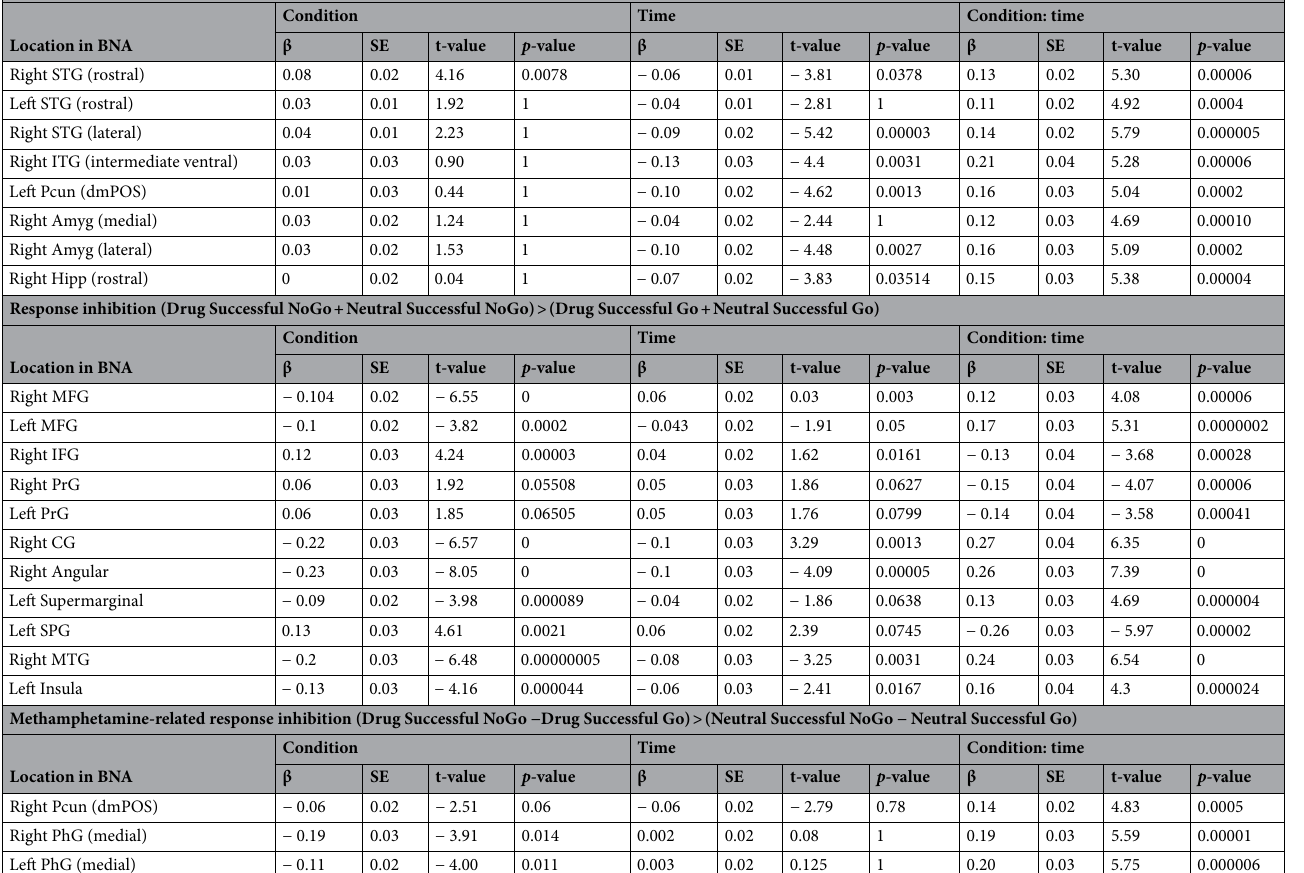
Table 2. Regions with significant condition by time interactions in the cue-reactivity and methamphetamine- related response inhibition linear mixed effects (LME) models. All p- values are FDR-corrected. FDR p-value threshold: 0.001. The p-values less than 1.0e−8 are considered as zero. The β, SE, and t-value are rounded to two decimal places. The response inhibition LME model revealed 107 regions with significant condition-by- time interactions, and complete results are shown in the Supplementary Table S1. In this table, results are shown only for regions implicated in a recent meta-analysis of fMRI studies with Go-NoGo tasks. FDR p-value threshold: 0.05. β Beta value, SE Standard Error, STG superior temporal gyrus, ITG inferior temporal gyrus, Pcun (dmPOS) dorsomedial parietooccipital sulcus part of precuneus, Amyg amygdala, Hipp